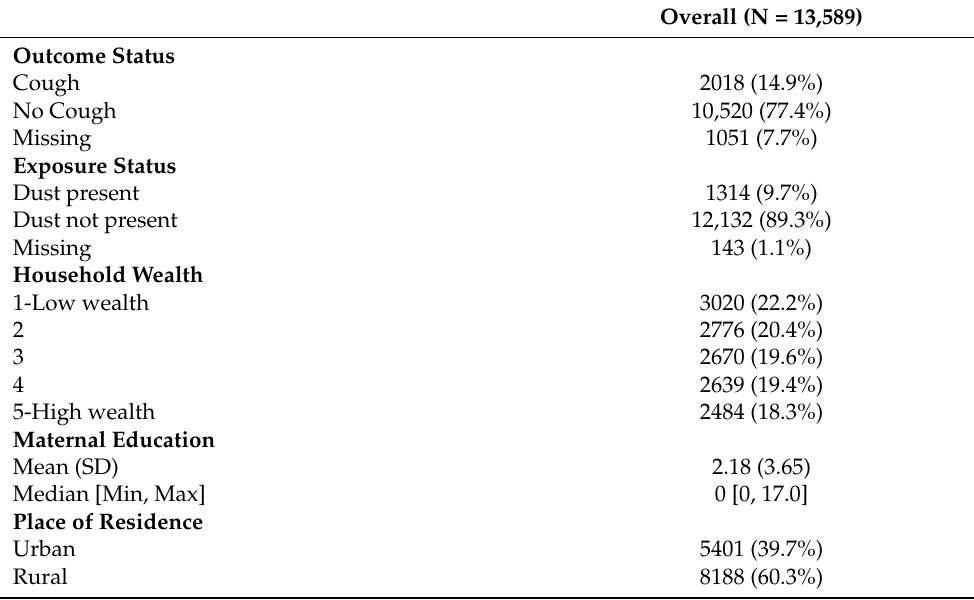
Table 1. Descriptive statistics of the study population of households of children under 5 in